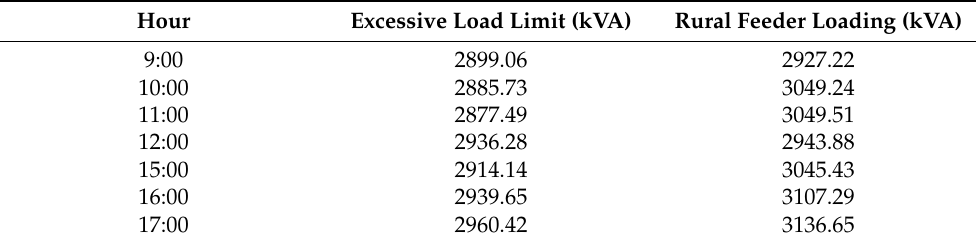
Table 8. Excessive loading limit violations on the Rural Feeder C. Source: The authors.